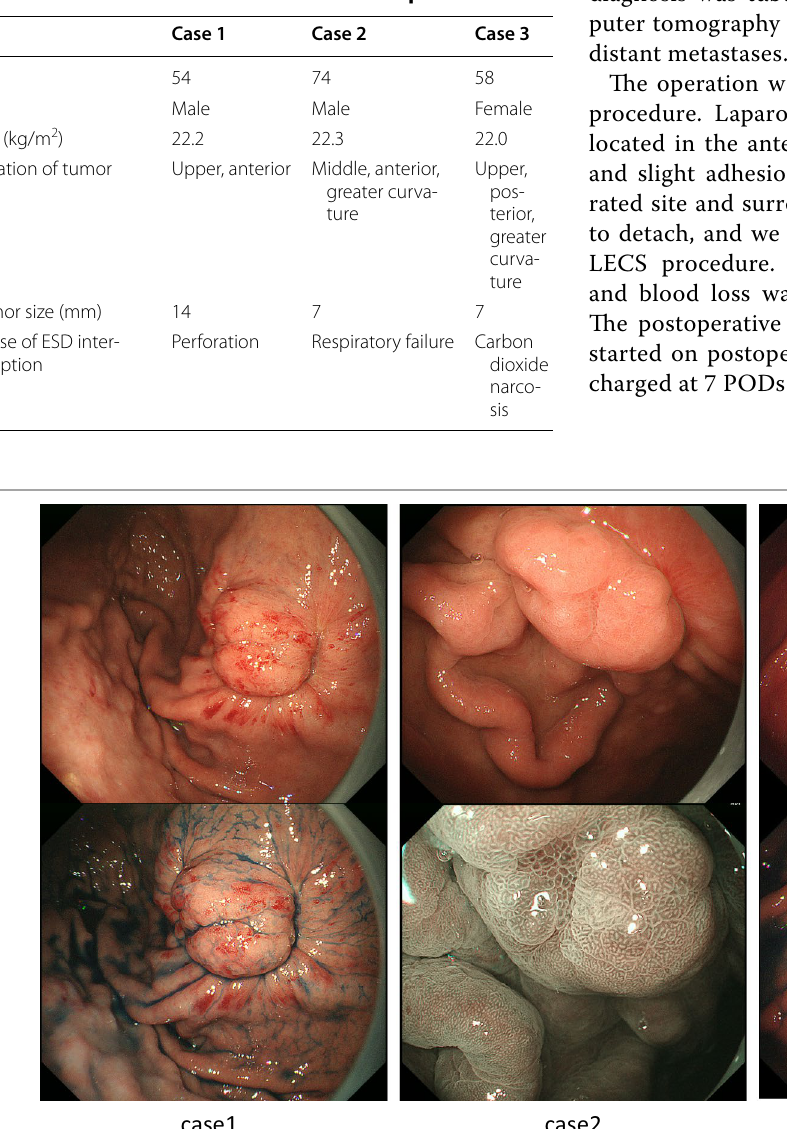
Table 1 Patients characteristics of the three patients